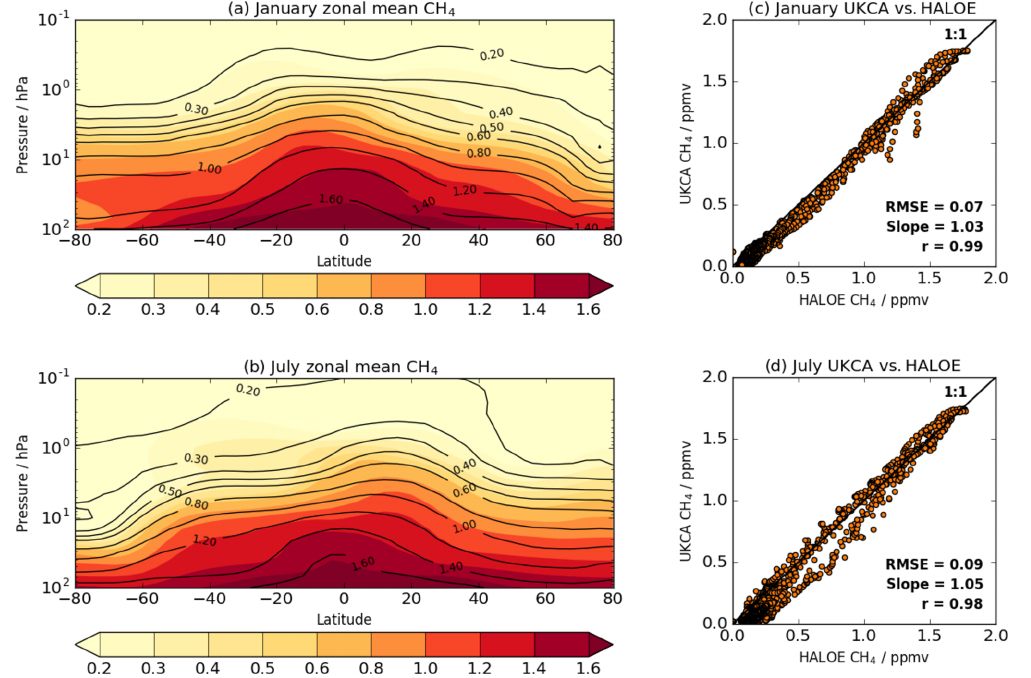
Figure 12. Multi-annual (2005–2014) monthly zonal mean methane (ppm) from the UKESM1 FR simulation in (a) January and (b) July, with scatter plots of modelled versus observed concentrations for January and July in panels (c) and (d) , respectively. The coloured contours in (a) and (b) are from UKCA and the black contours are the HALOE/CLAES climatology. The scatter plots also include a 1:1 line as well as the root mean square error (RMSE), the slope of a least squares linear fit and the correlation coefficient ( r ).